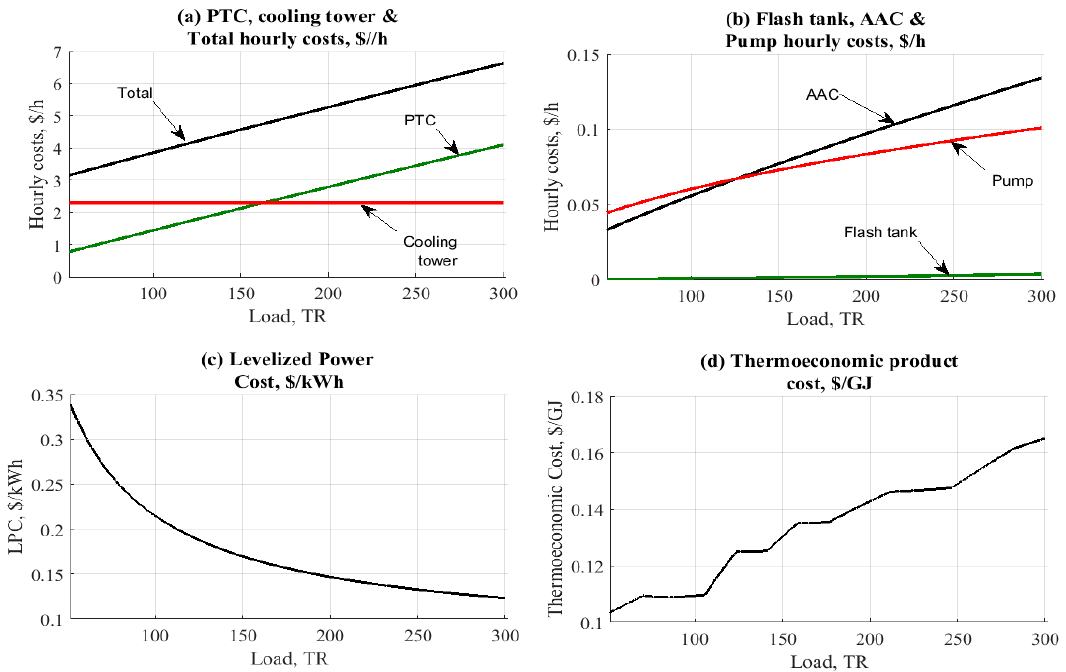
Figure 9. Data results based on the effect of cooling load.